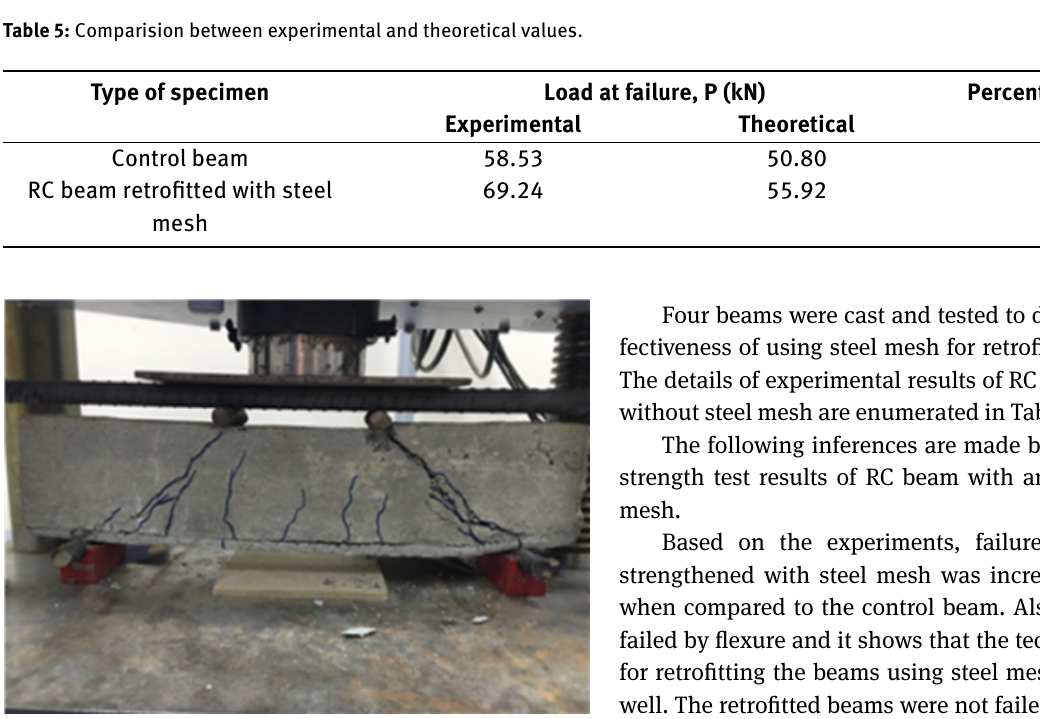
Figure 13: Failure pattern of retrofitted specimen.